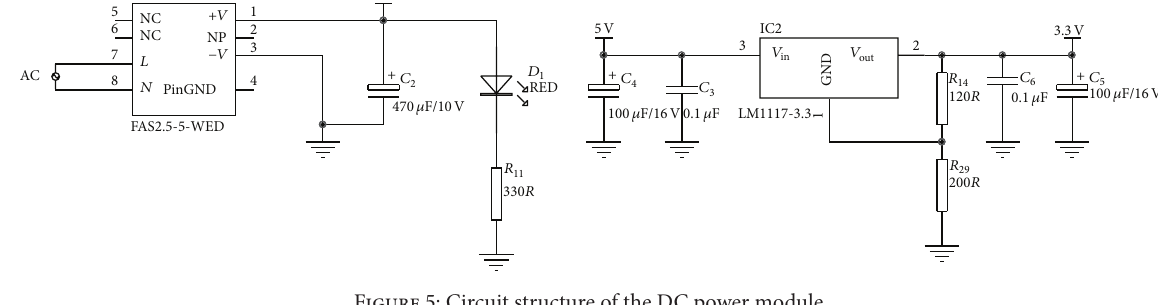
Figure 5: Circuit structure of the DC power module.